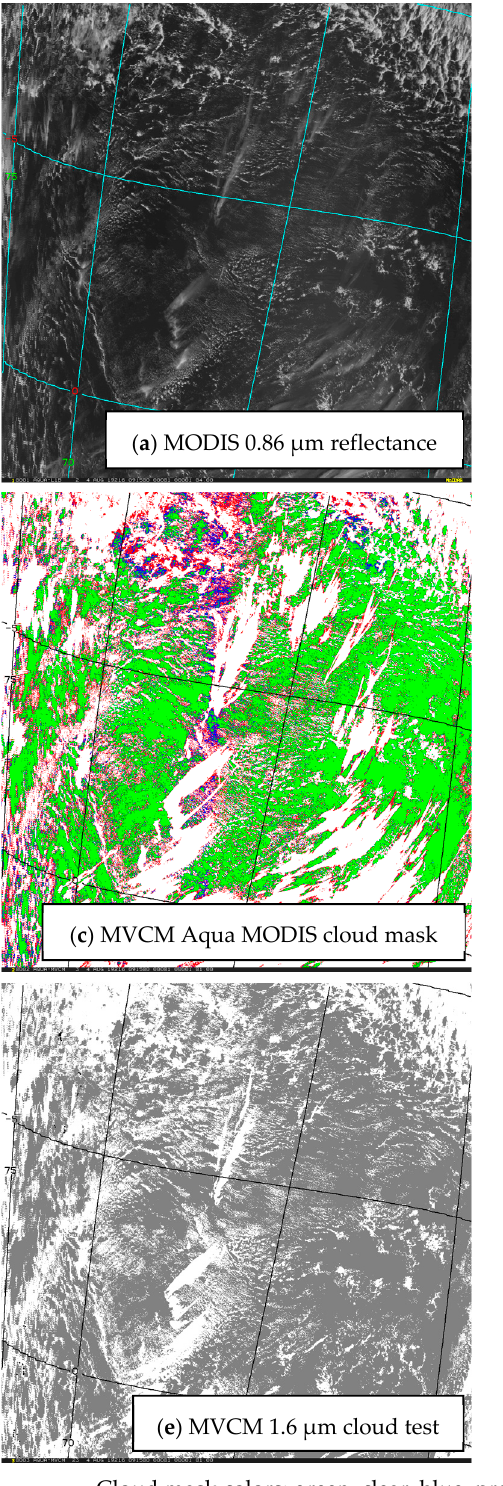
Cloud mask colors: green=clear, blue=prob. clear, red=prob. cloud, white=cloud Figure 1. Example MVCM Aqua MODIS output from 04 August, 2019 at 09:15 UTC; ( a ) MODIS 0.86 µm reflectance; ( b ) MODIS 1.38 µm reflectance; ( c ) representation of final output cloud mask; ( d ) results of the 1.38 µm cloud test; ( e ) results of the 1.6 µm cloud test; ( f ) results of the 8.6 µm cloud test.